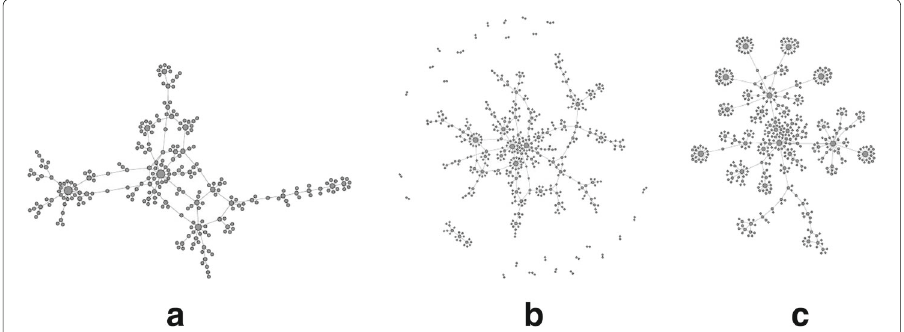
Fig. 8 Colorado Springs epidemiological contact network. a original network, b scale-2 replica and c sample from a scale-200000